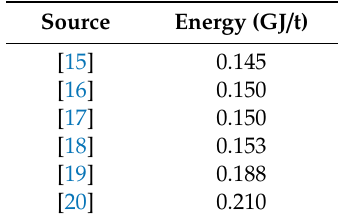
Table 1. Bauxite mining energy per ton of bauxite.